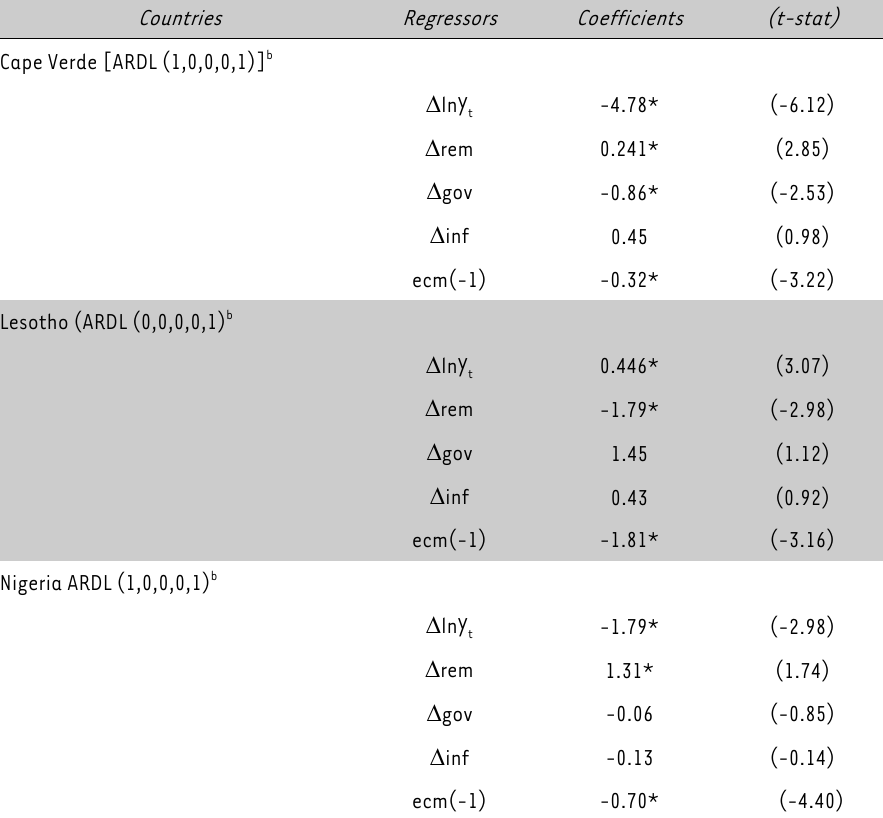
TABLE 5: Error Correction Representation for the Selected ARDL Model Countries Regressors Coefficients (t-stat) Cape Verde [ARDL (1,0,0,0,1)]